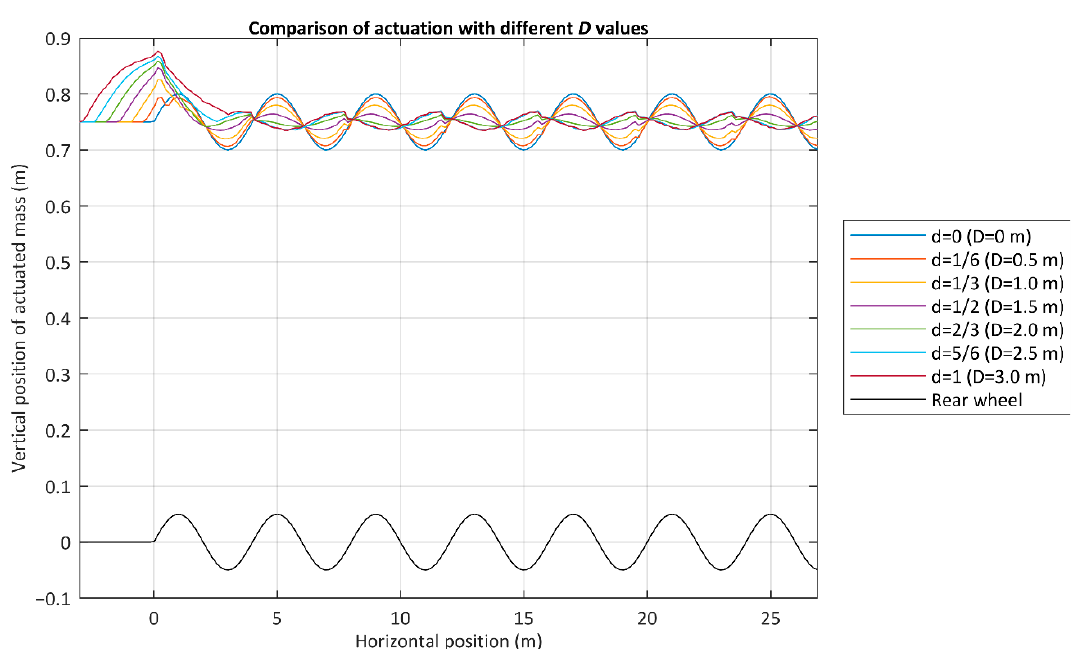
Figure 11. Displacement of the actuated mass in the first ground profile.